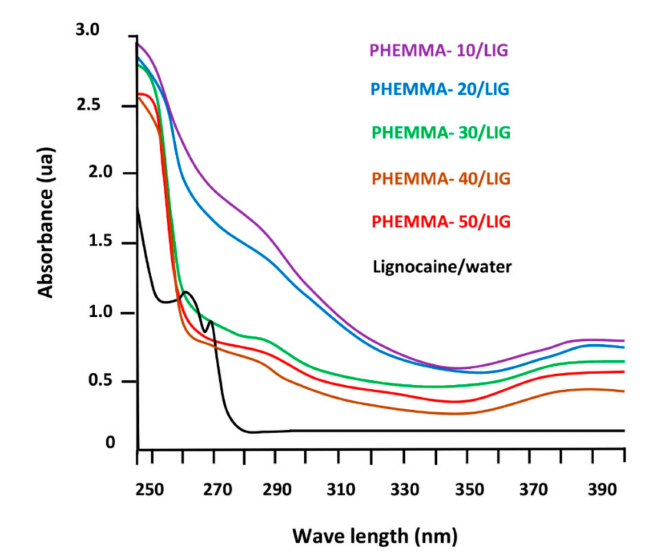
Figure 10. Spectra of the wet PHEMMAC / LIG with di ff erent MMA contents: ( A ) LIG / water; 13.26 mol %; ( B ) 22.18 mol %; ( C ) 33.21 mol %; ( D ) 48.56 mol %; and ( E ) 63.32 mol % recorded in the visible light domain (240–400